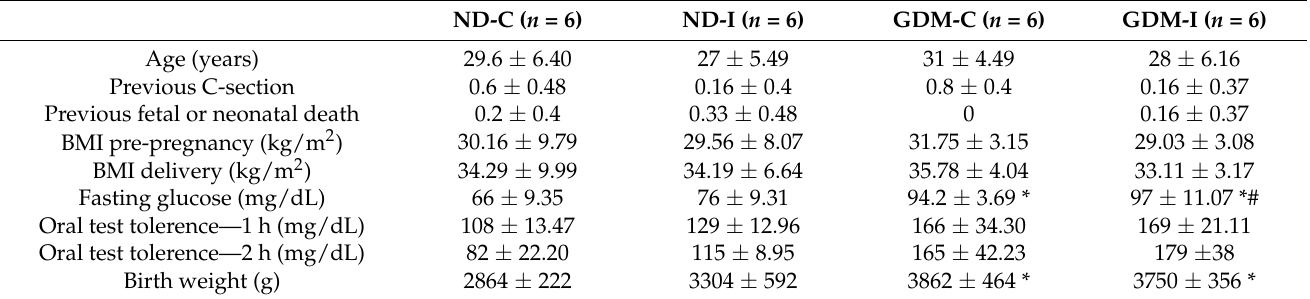
Table 1. Singleton pregnant participants recruited to the DIAMATER study cohort: baseline charac- teristics of women with and without GDM and